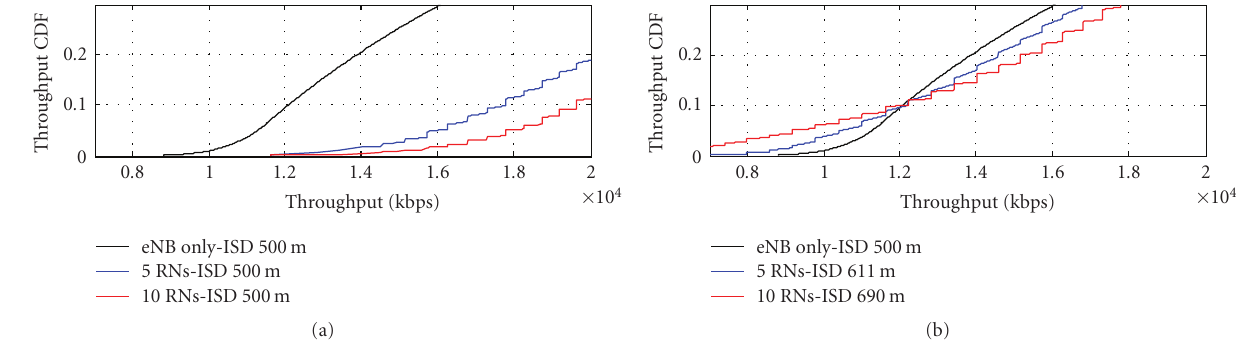
Figure 1: Translating relay throughput gains into coverage